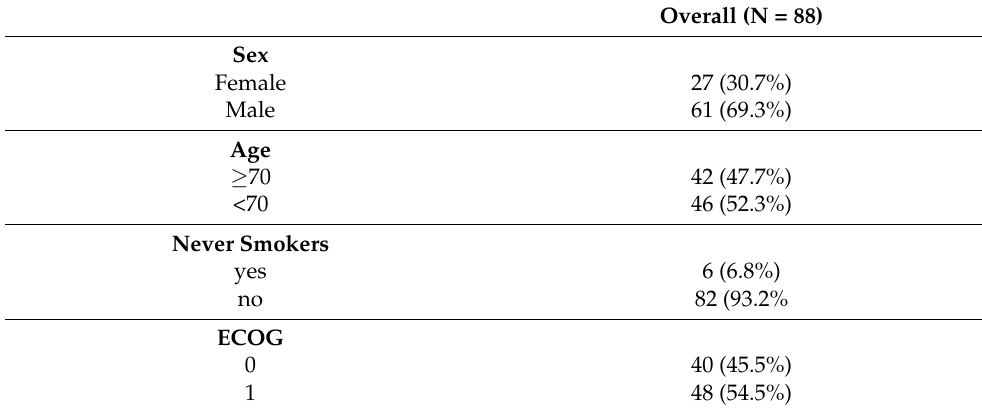
Table 1. Descriptive statistics of clinic − pathological variables of study